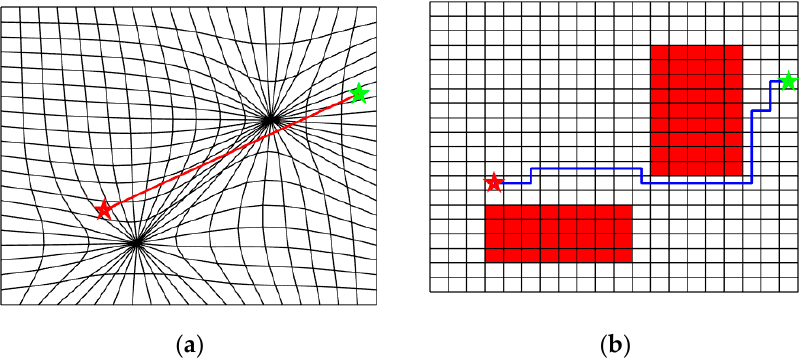
Figure 7. ( a ) The resulted DC-space for the situation in Figure 4. The start position and the target position are connected with one straight line directly. ( b ) The effective path after projecting the path back to